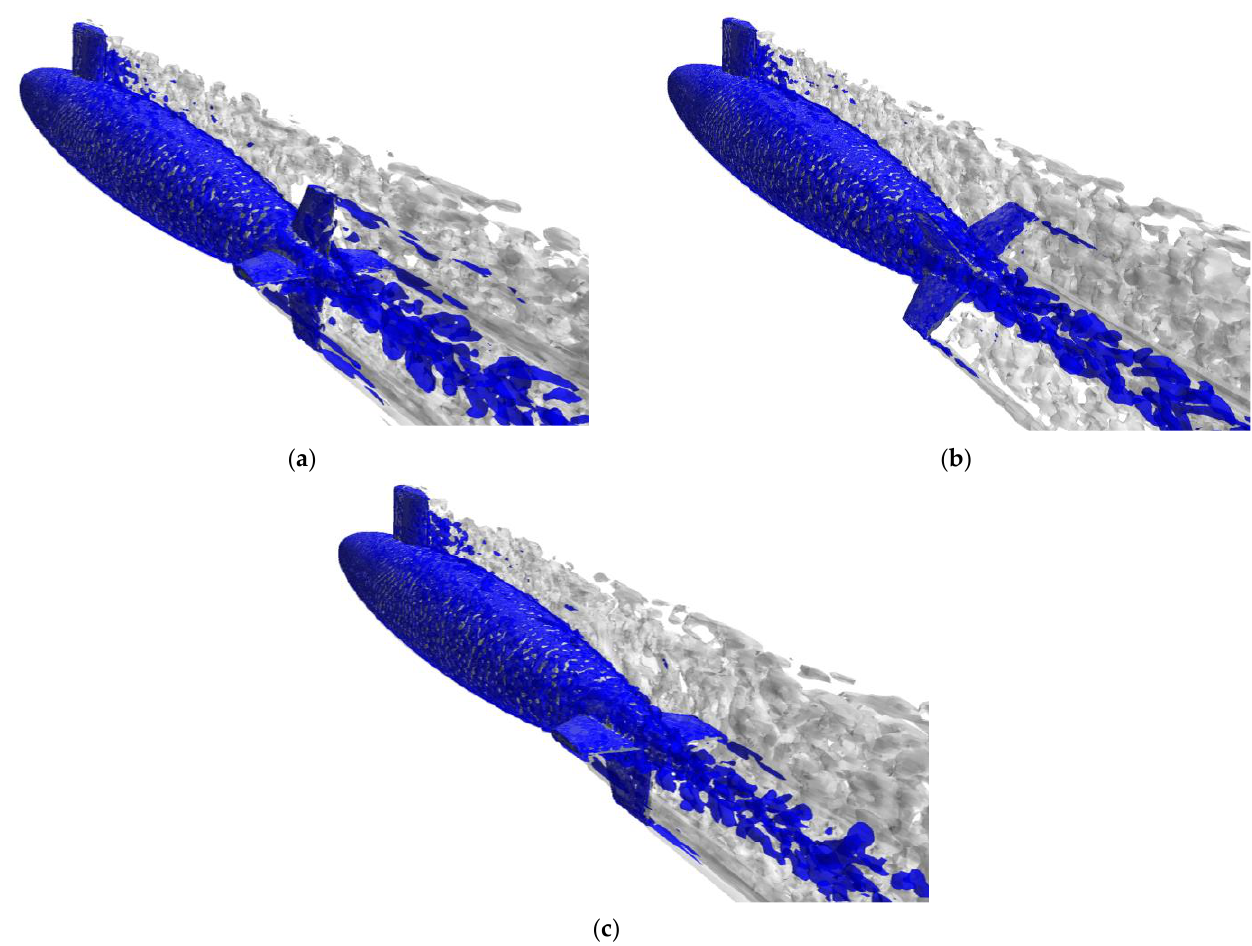
Figure 16. Cloud map of Q-contour surface of an underwater vehicle with full appendages (blue Q = 100 s − 2 gray Q = 1 s − 2 ): ( a ) cross-type rudders; ( b ) X-type rudders; ( c ) T-type rudders.